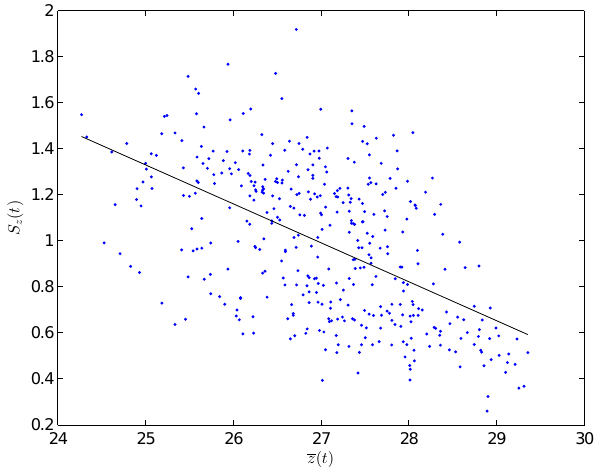
Figure 2. Spatial standard deviation, S z ( t ), vs. spatial mean, z ( t ), in the Niño 3.4 region, for all t ∈ D t , with the WTS-estimated line superimposed. Units on both axes are ◦